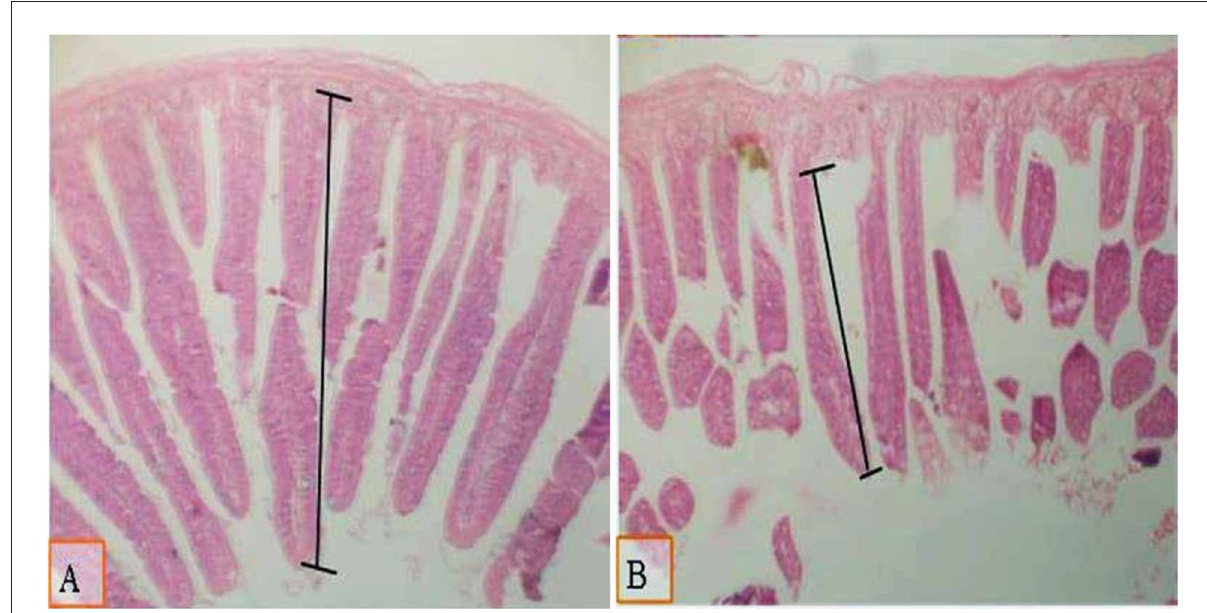
FIGURE1 Micrograph of the intestine of 28 d of age broilers using HandE stain (X40) and measured from the base to apex to investigate the villous length in the various experimental groups: (A) the group fed on standard diet with 0.1% of multi-enzymes (B) the same feed group supplemented with 0.2% of multi-enzymes. Moderate increase in villous length was noted in broilers fed on dietary feed with 0.1% of multi-enzymes (A)